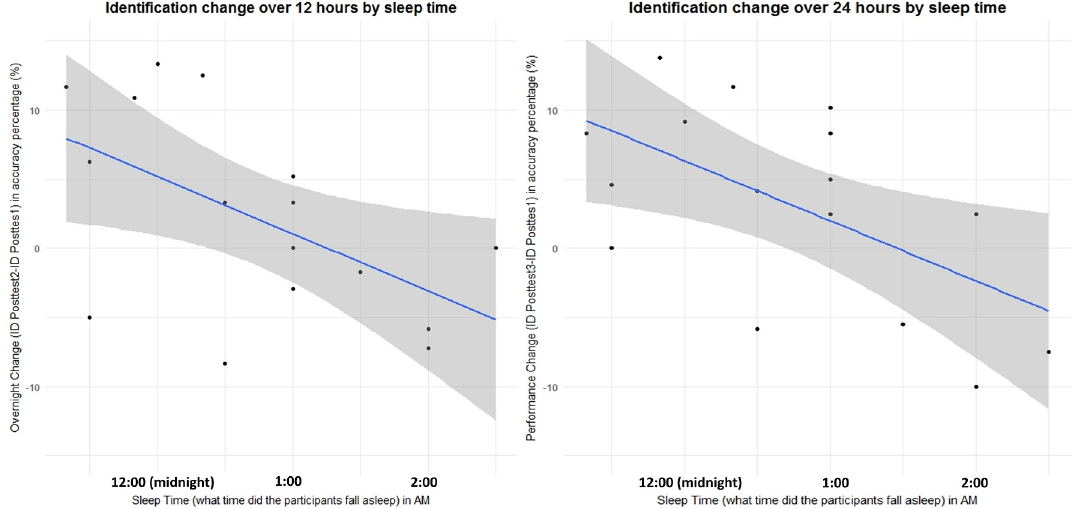
Fig 6. Relationships between individual differences in sleep time (in AM) and the performance (accuracy percentage in %) changes over 12 hours (left) and 24 hours (right) to the identification task performance. The shaded areas represent a 5% confidence